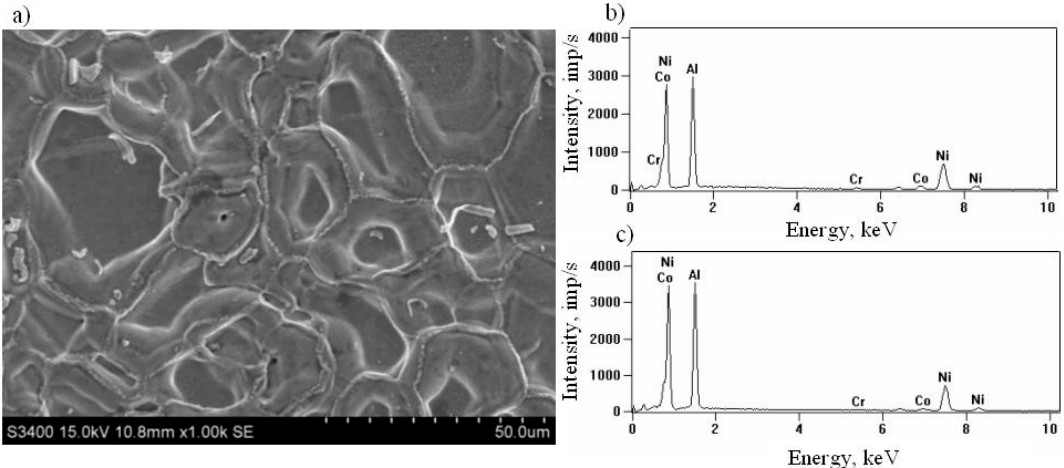
Figure 1. Surface morphology ( a ), Energy Dispersive Spectrum EDS of grain core ( b ), and EDS spectrum of grain boundary ( c ) of the nonmodified aluminide coating.